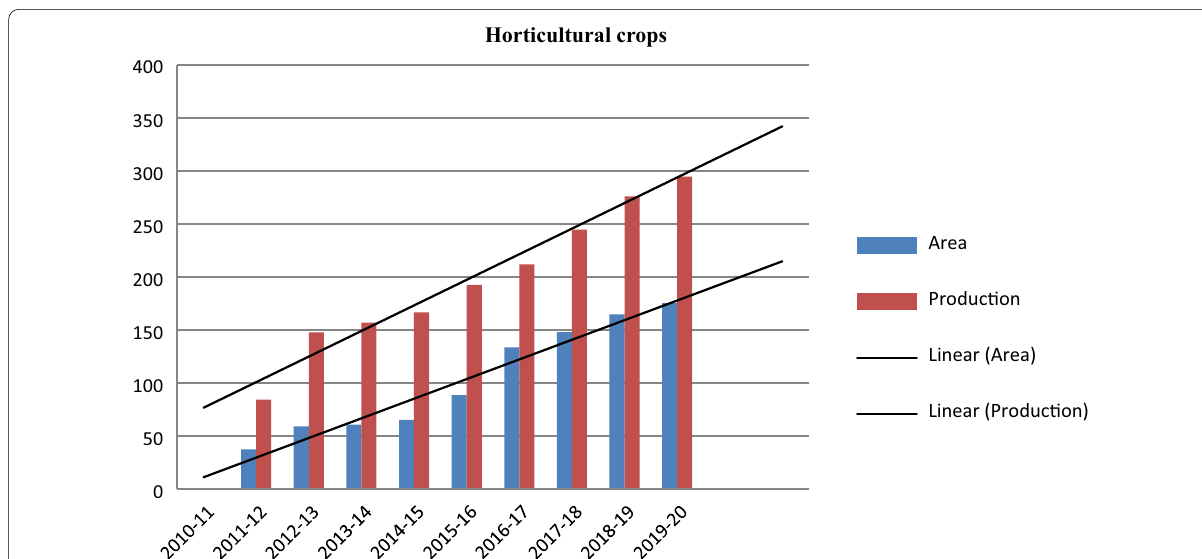
Fig. 12 Growth rate (%) in area and production of horticultural crops in Madhya Pradesh state during the decade 2010–2020 depict a continuous and consistent increase in the growth rate per year in the area under these crops and its linear forecast points towards a positive growth trend in future as well